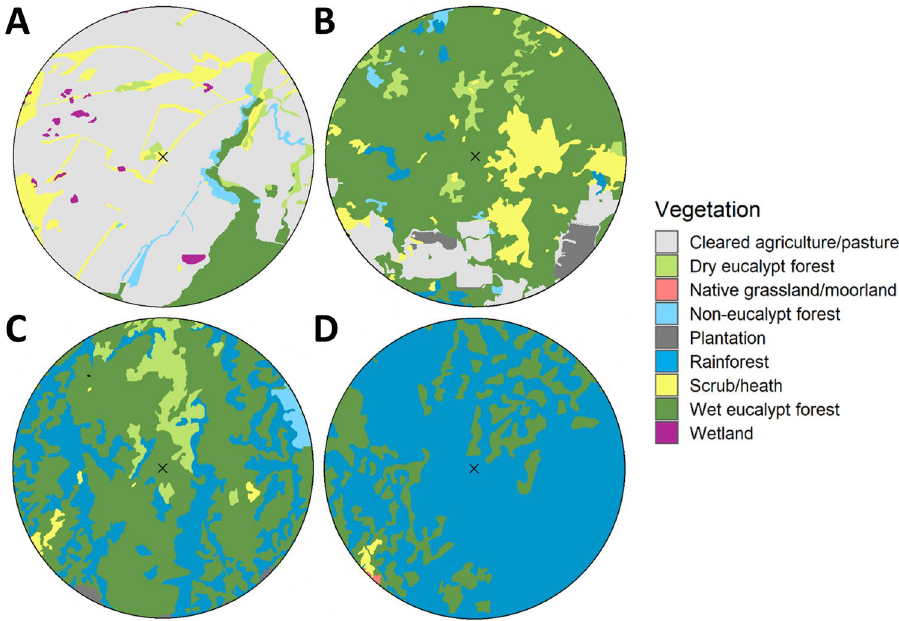
Figure 2. Examples of estimated 2,531 hectare home ranges surrounding four trapping locations (indicated by x) for each major habitat category: ( A ) cleared land; ( B ) wet eucalypt forest-other; ( C ) wet eucalypt forest- rainforest; and ( D )